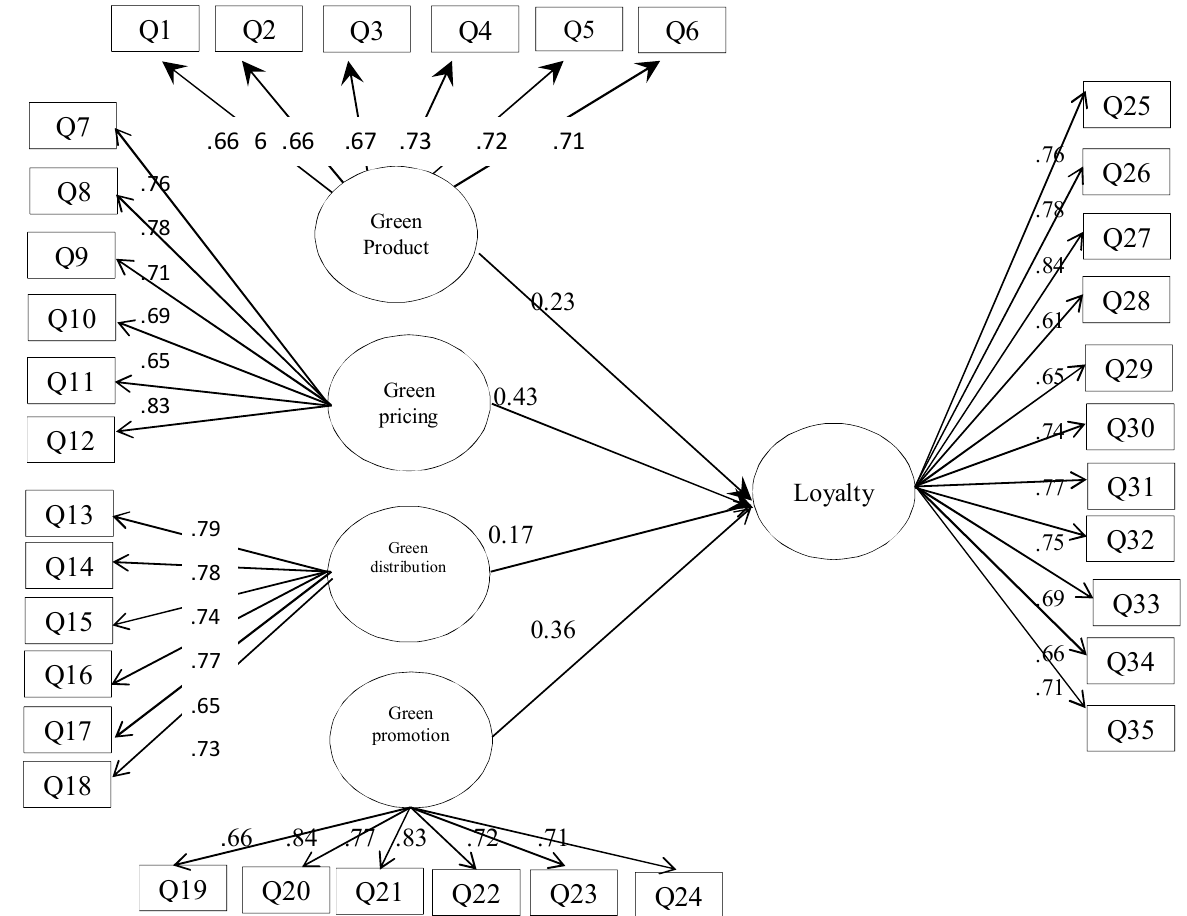
Fig. 2. The results of structural equation